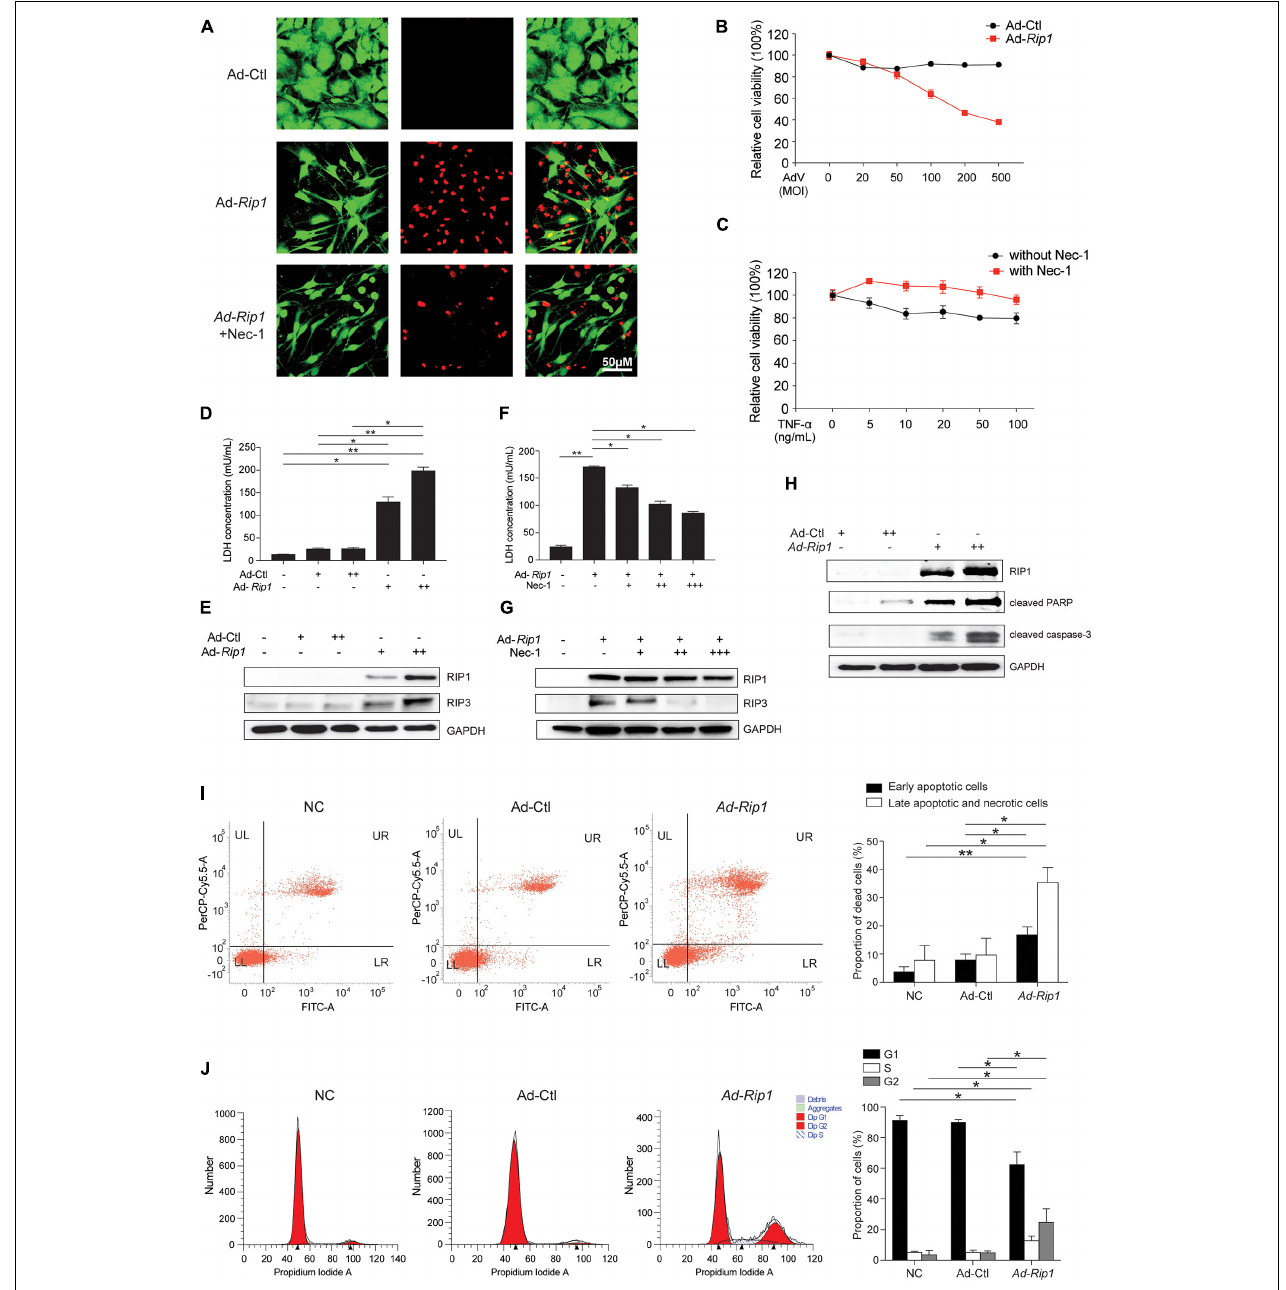
FIGURE 2 | Overexpression of RIP1 in chondrocytes causes necroptosis and apoptosis. (A) Live-dead staining of rat chondrocytes treated with Ad-Ctl (100 MOI), Ad- Rip1 , or Ad- Rip1 with 50 µ M Nec-1 ( n = 3 for each group). Green fluorescence: live cells; red fluorescence: dead cells. (B) Relative cell viability of rat chondrocytes assessed by CCK-8 assay after treatment with indicated MOI of Ad-Ctl or Ad- Rip1 for 24 h ( n = 6 for each group). (C) Relative cell viability of rat chondrocytes assessed by CCK-8 assay after treatment with indicated doses of TNF- α with or without 50 µ M Nec-1 for 24 h ( n = 6 for each group). (D) LDH concentrations in the cultural supernatant of rat chondrocytes treated with Ad-Ctl (100, 200 MOI) or Ad- Rip1 for 24 h ( n = 3 for each group; three independent experiments). (E) The protein levels of RIP1 and RIP3 detected by western blotting assay in rat chondrocytes treated with Ad-Ctl (100, 200 MOI) or Ad- Rip1 for 24 h. (F) LDH concentrations in the cultural supernatant of rat chondrocytes treated with Ad-Ctl (100 MOI), Ad- Rip1 or Ad- Rip1 and Nec-1 (50, 100, and 200 µ M) for 24 h ( n = 3 for each group; three independent experiments). (G) The protein levels of RIP1 and RIP3 detected by western blotting assay in rat chondrocytes treated with Ad-Ctl (100 MOI), Ad- Rip1 or Ad- Rip1 and Nec-1 (50, 100, and 200 µ M) for 24 h. (H) The protein levels of RIP1 and cleaved PARP and cleaved caspase-3 detected by western blotting assay in rat chondrocytes treated with Ad-Ctl (100, 200 MOI) or Ad- Rip1 for 48 h. (I) Necrotic and apoptotic rat chondrocytes stained by annexin V and PI and analyzed by flow cytometry after treatment with Ad-Ctl (100 MOI) or Ad- Rip1 for 24 h, rat chondrocytes without treatment were used as negative control ( n = 3 for each group; three independent experiments). (J) Cell cycle distribution of rat chondrocytes treated with Ad-Ctl (100 MOI) or Ad- Rip1 for 24 h, rat chondrocytes without treatment were used as negative control ( n = 3 for each group; three independent experiments). * P < 0.05 and ** P < 0.01.